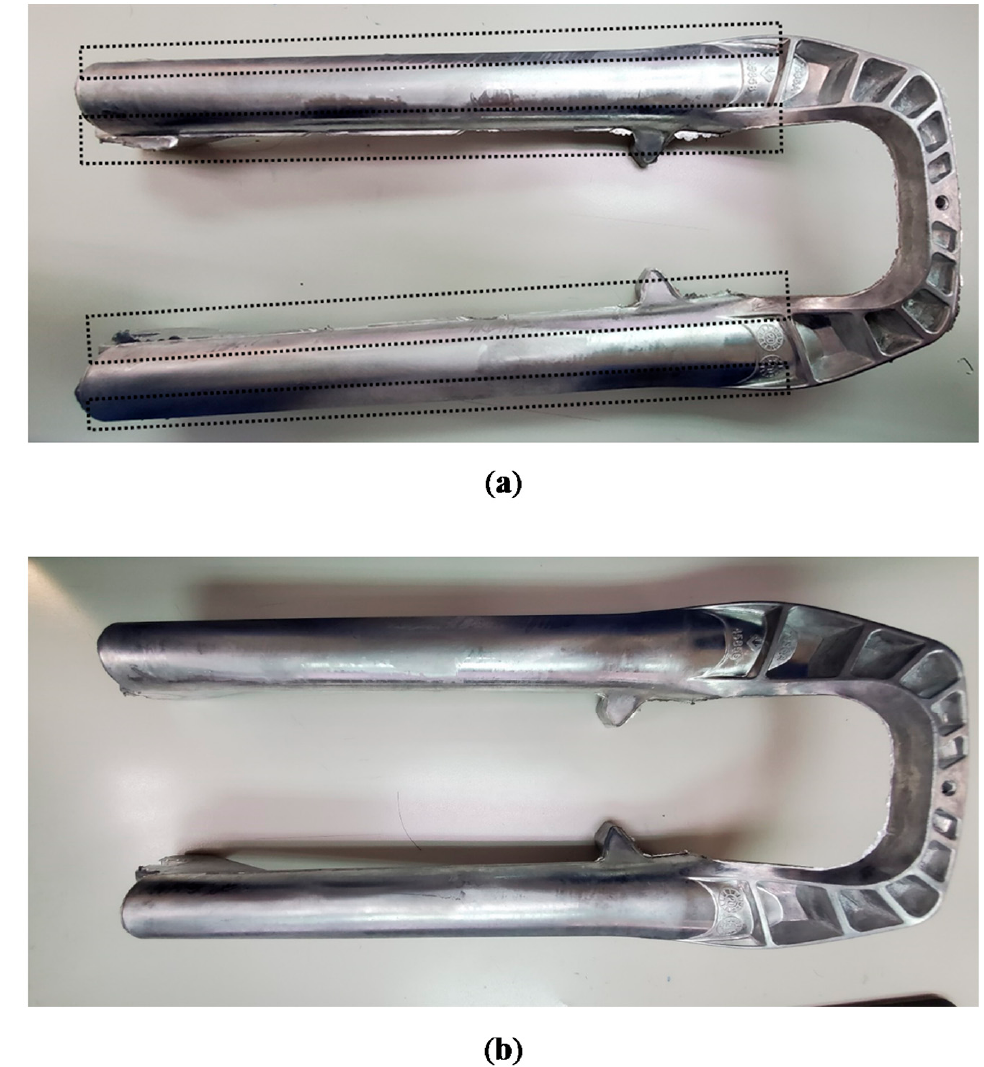
Figure 12. Bicycle fork ( a ) before and ( b ) after processing.